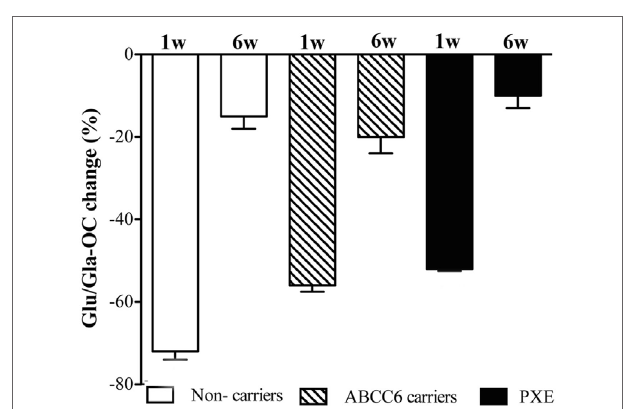
FigUre 2 | Ratio of circulating Glu-osteocalcin (Glu-OC) and Gla-osteocalcin (Gla-OC) measured by ELISA in pseudoxanthoma elasticum (PXE) patients, in heterozygous ABCC6 mutation carriers (ABCC6 carriers) and in non-carriers after 1 and 6 weeks post-phytomenadione administration. Data are expressed as percentage reduction (means value ± SD) compared to baseline ( p < 0.05 along time for the three groups).